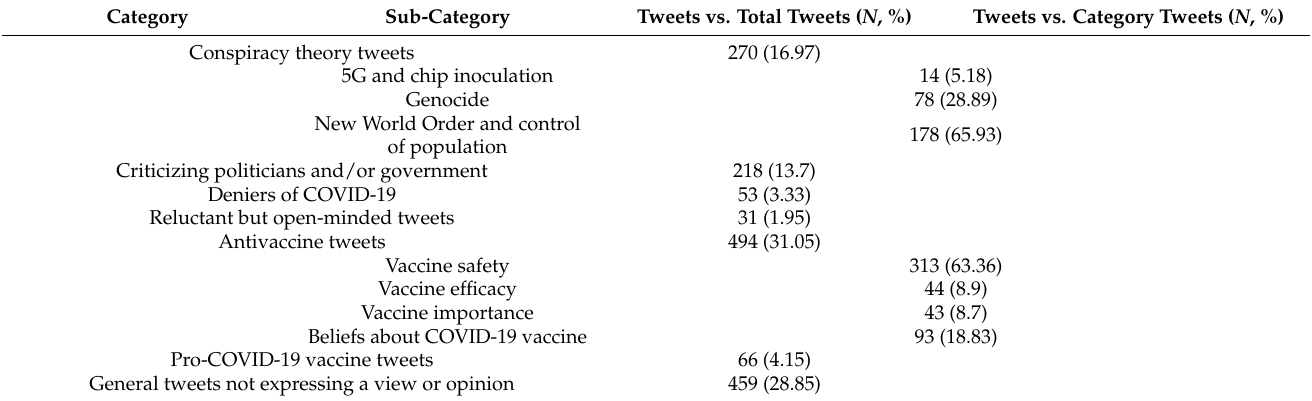
Table 3. Content analysis of individual tweets from